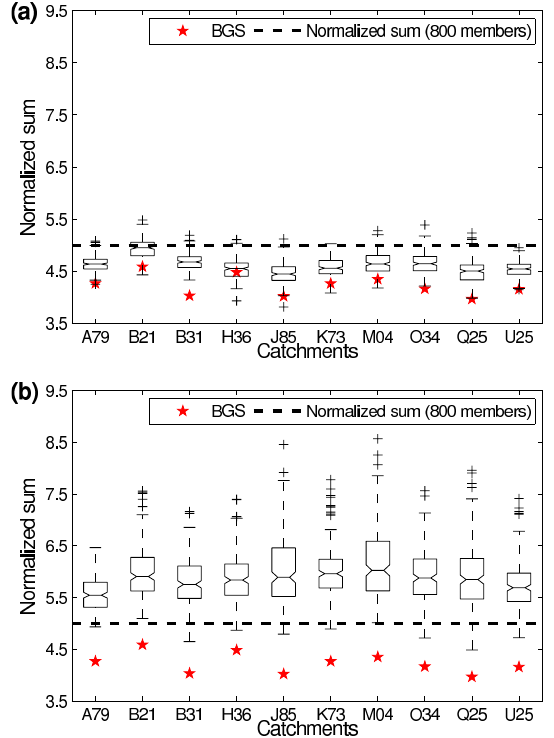
Fig. 6. Backward Greedy Selection (BGS) and Box-plots in 200 random experiments of 50 hydrological members for the lead time 9. On each box, the central mark is the median, the edges of the box are the 25th ( Q 1 ) and 75th percentiles ( Q 3 ), the whiskers or limits to consider the outliers extend from Q 1 − 1.5 × ( Q 3 − Q 1 ) to Q 3 +1.5 × ( Q 3 − Q 1 ) points (but not necessarily correspond to observed data), and the outliers are plotted individually as cross points. (a) Random selection oriented with the frequency observed in the BGS to check the interchangeability in the 800 member-set, (b) Random selection without any guidance to check the BGS per-